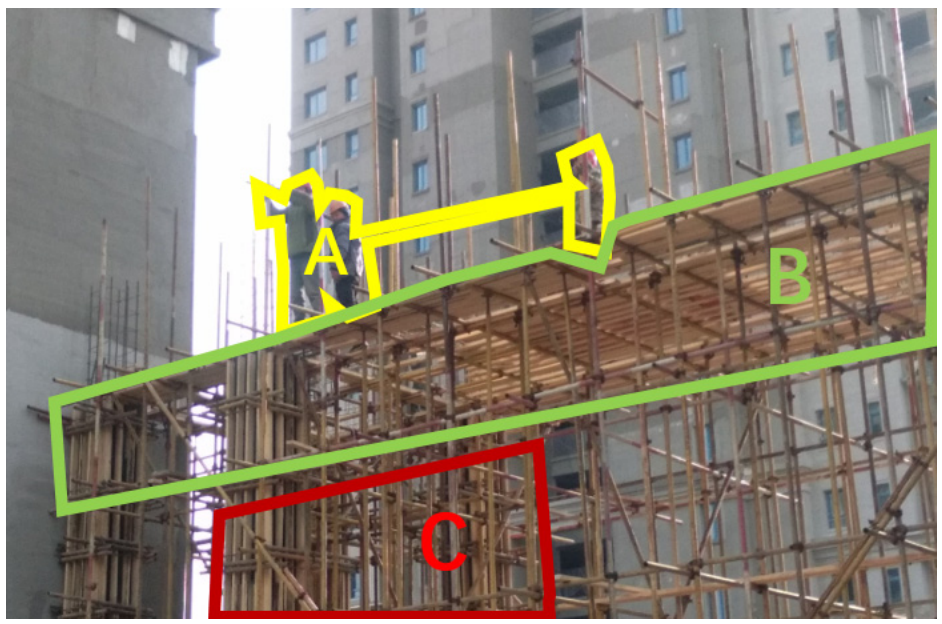
Figure 6. PPE failure (Hazard #3).